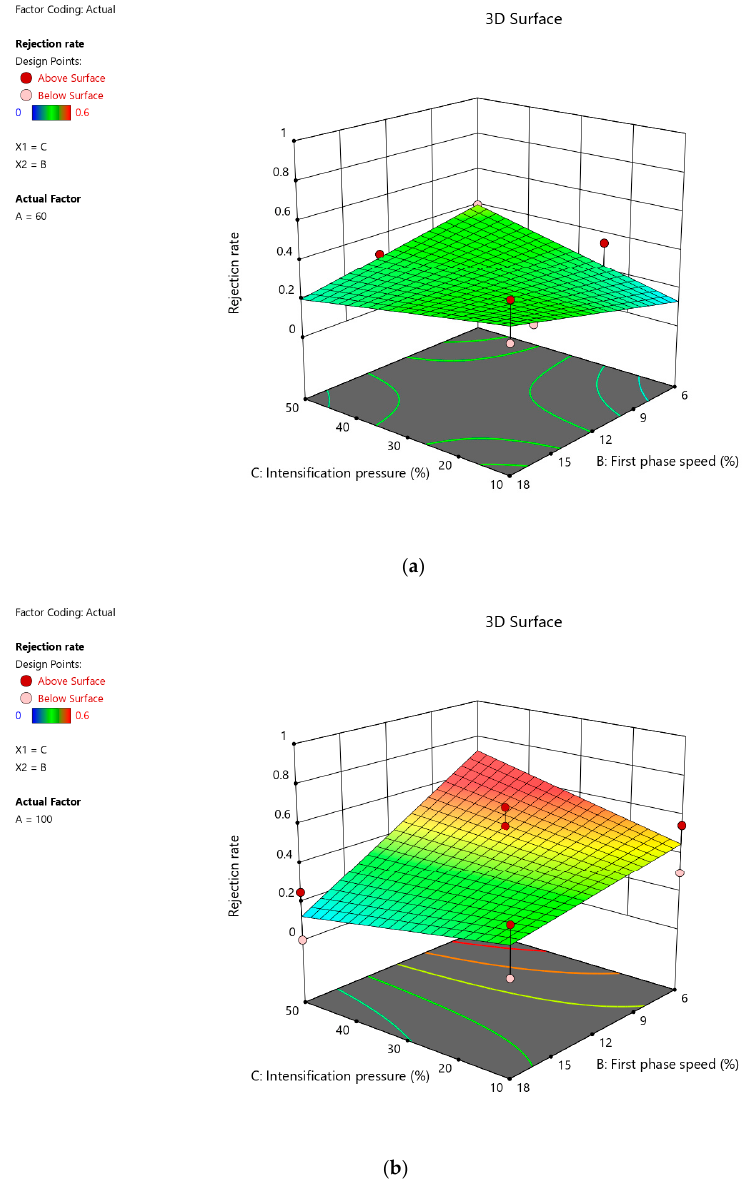
Figure 2. Model response on total rejection rate ( a ) A—First phase switch point set to 60mm and ( b ) A—First phase switch point set to 100 mm.